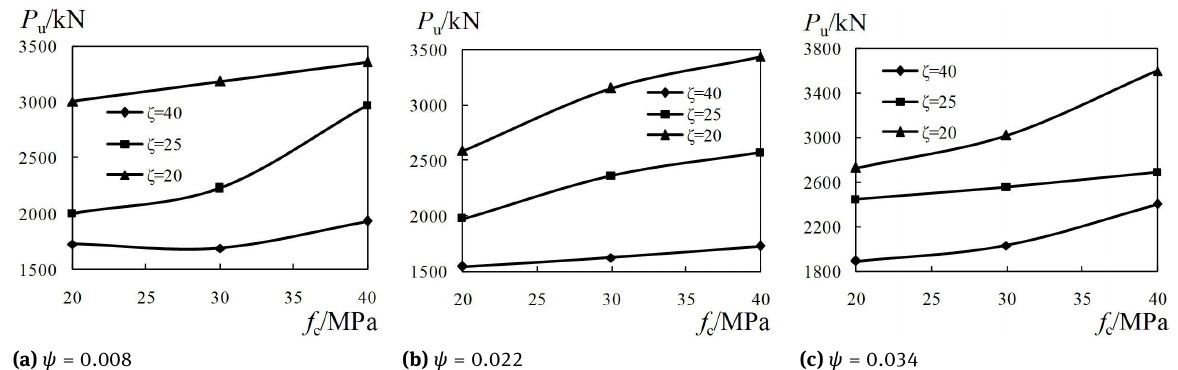
Figure 14: Ultimate load versus nano-silica concrete strength